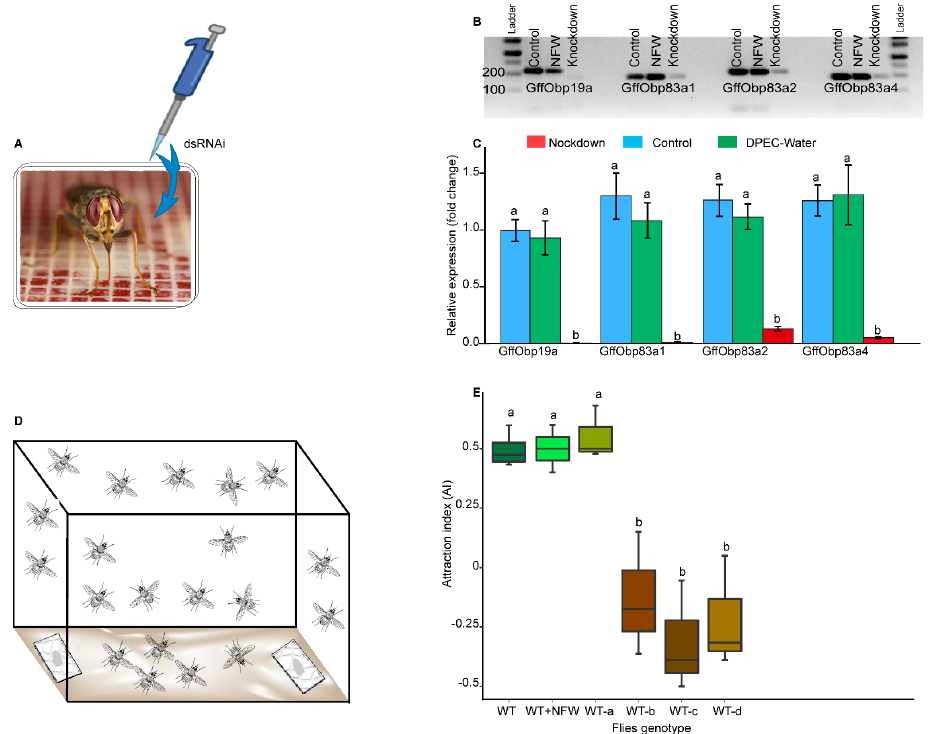
Figure 4. Schematic representation of the RNAi experiment and its effect on odorant-binding protein (OBP) expression and on fly behavior. ( A ): dsRNAi delivery and fly conditioning after dsRNAi intake. ( B , C ): comparative expression of different OBPs in wild-type and knockdown flies using real-time qPCR. ( D ): behavioral assay set-up. ( E ): Boxplots illustrating the attraction index (AI) of various G. f. fuscipes genotypes (WT = wild-type, WT + nfw = nuclease-free water, WT-a = Obp19a-silenced, WT-b = Obp83a1-silenced, WT-c = Obp83a2-silenced= and WT-d = Obp83a4-silenced. Box plots with different letters are significantly different from each other using ANOVA followed by Tukey’s test.